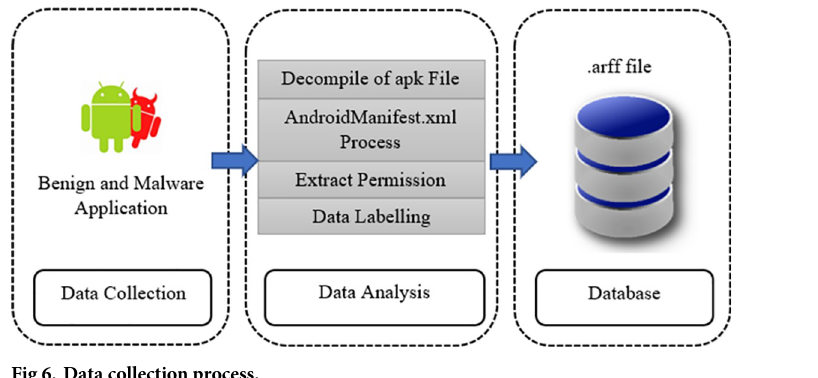
Fig 6. Data collection